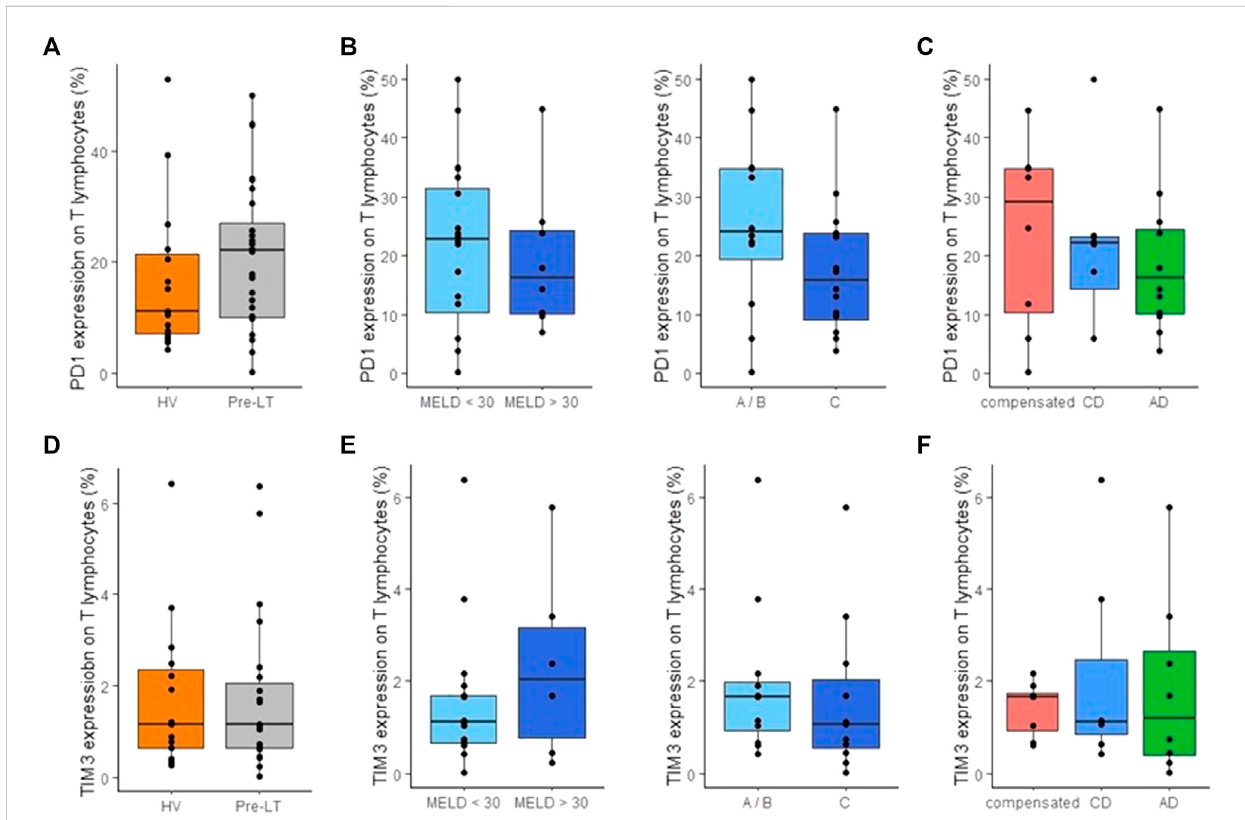
FIGURE 5 Monitoring of PD-1 and TIM3 expression on T cells in peripheral blood of pre-transplant patients. (A) Percentage of PD-1 expression on CD3+ T lymphocytesinhealthyvolunteers(HV, n =15)andpre-transplantpatients(pre-LT, n =28). (B) PercentageofPD-1expressiononCD3+Tlymphocytesin patients with a MELD score < 30 ( n = 20) or with a MELD score ≥ 30 ( n = 8) and in patients with Child-Pugh score A or B (A/B, n = 12) or with Child-Pugh scoreC( n =16). (C) PercentageofPD-1expressiononCD3+Tlymphocytesinpatientswithcompensatedcirrhosis( n =8),chronicdecompensated cirrhosis (CD, n = 8) and acute decompensated cirrhosis (AD, with n = 10 or without ACLF n = 2). (D) Percentage of TIM3 expression on CD3+ T lymphocytes in healthy volunteers (HV) and pre-transplant patients (pre-LT). (E) Percentage of TIM3 expression on CD3= T lymphocytes in patients with compensated,chronicdecompensated, andacutedecompensatedcirrhosis. (F) PercentageofPD-1expressiononCD3+Tlymphocytesinpatientswith orwithoutaMELD score < 30andin patients with Child-Pugh A/BorC. The nonparametricWilcoxon testwas used toassess variationsbetween patients and HV and between patients ’ subgroups determined by MELD and Child-Pugh score. Kruskal-Wallis test was used to assess differences between more than 2 independent